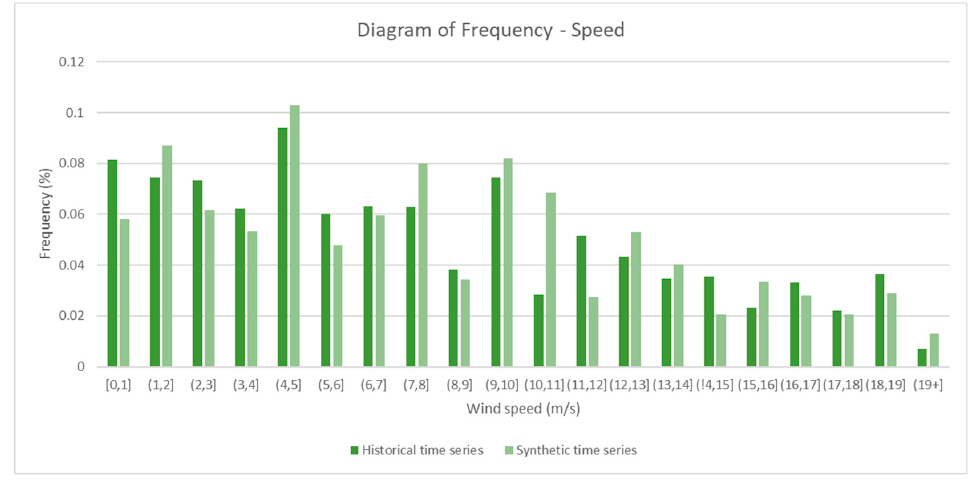
Figure 3. Diagram of frequency–speed.